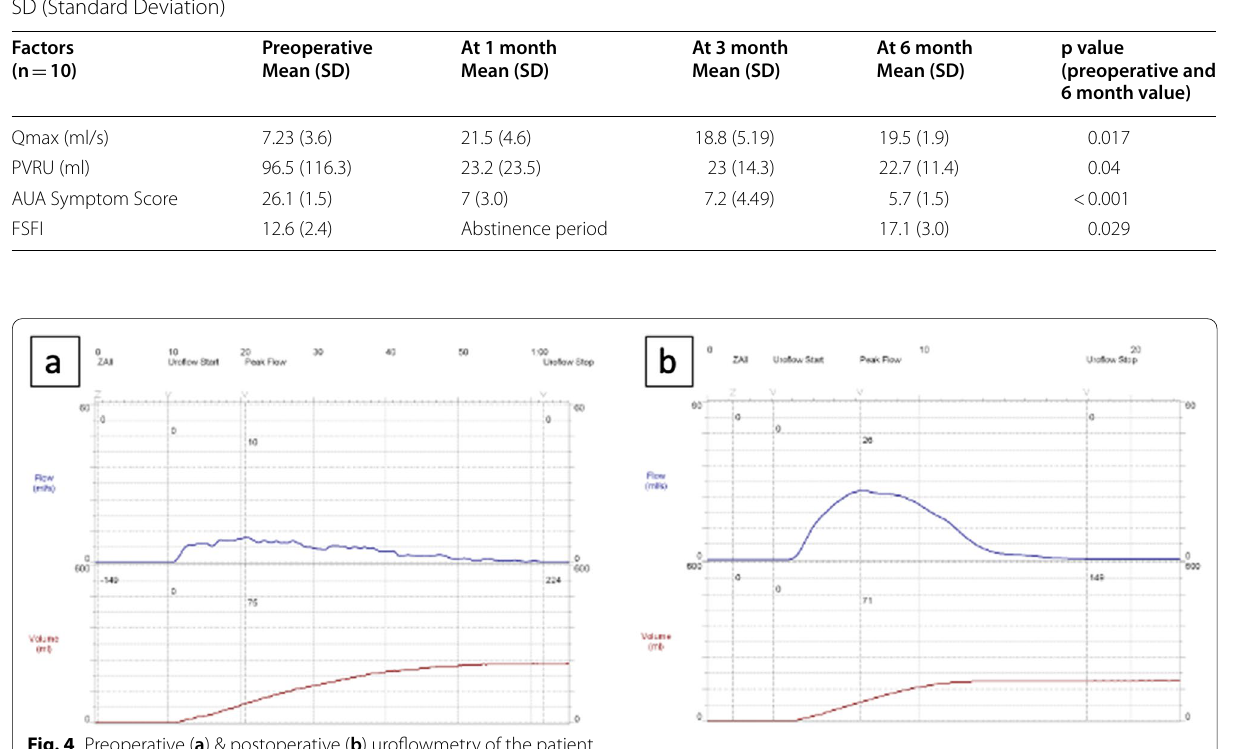
Table 1 Comparison of preoperative and postoperative values of Qmax, PVRU, AUA symptom scores and FSFI scores. Qmax (Peak Flow Rate), PVRU (Post-void Residual Urine), AUA (American Urology Association Symptom Score), FSFI (Female Sexual Function Index),